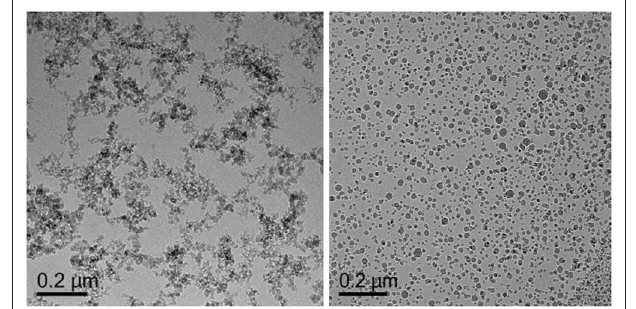
FIGURE 1 | Cryo-TEM image of nanoparticles: Right : FNP; Left : CNP.